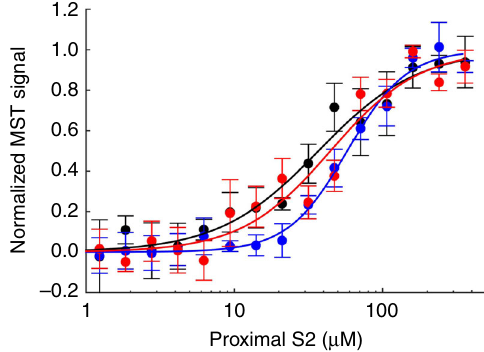
Fig. 2 Mutations R719W and D382Y do not affect proximal S2 binding. Microscale thermophoresis of WT (black), R719W (blue), and D382Y (red) 2-hep HMM titrated with proximal S2. Representative data from one preparation of myosin, and three experimental repeats. Error bars represent the SEM. Source data are provided as a Source Data fi